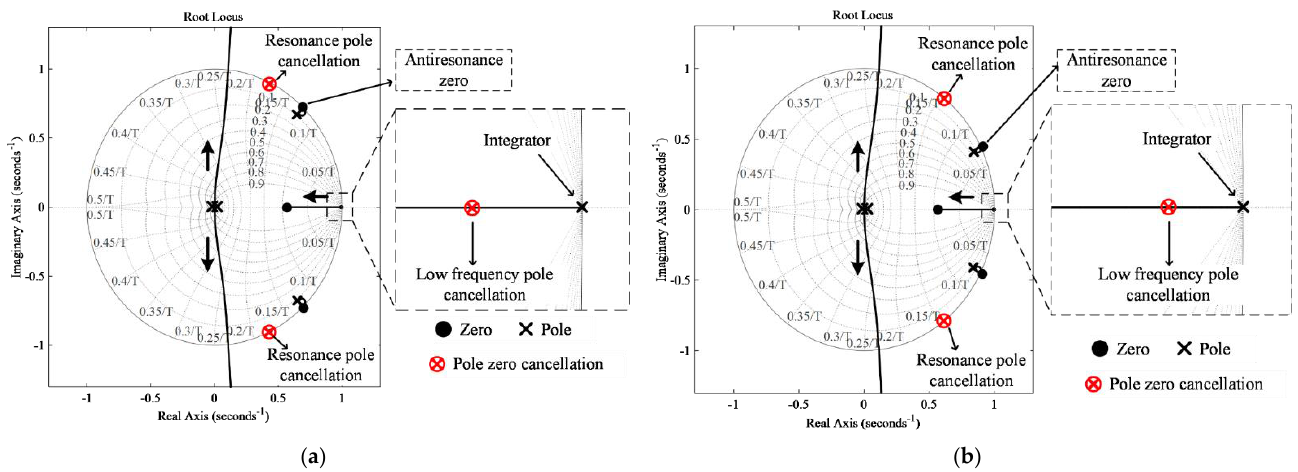
Figure 17. Root locus of loop gain transfer function for the LCL filter type GcI with RESO-based ADRC ( a ) For L grid = 0; ( b ) For L grid = 4 mH. Table 7. Stability Analysis with the Proposed RESO Based ADRC for the LCL Filter Type GcI.